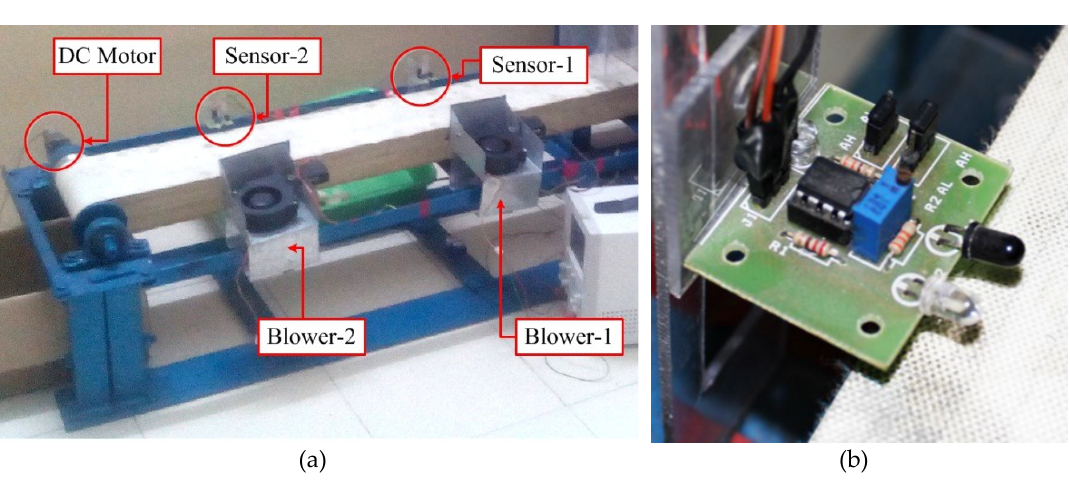
Figure 11. ( a ) Horizontal Conveyor Module; ( b ) IR proximity sensor close-up.